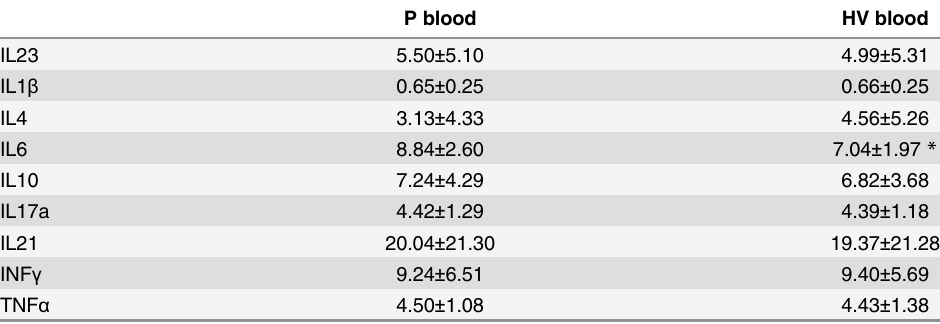
Table 3. Cytokine levels (pg/mL) in the overall patient group.